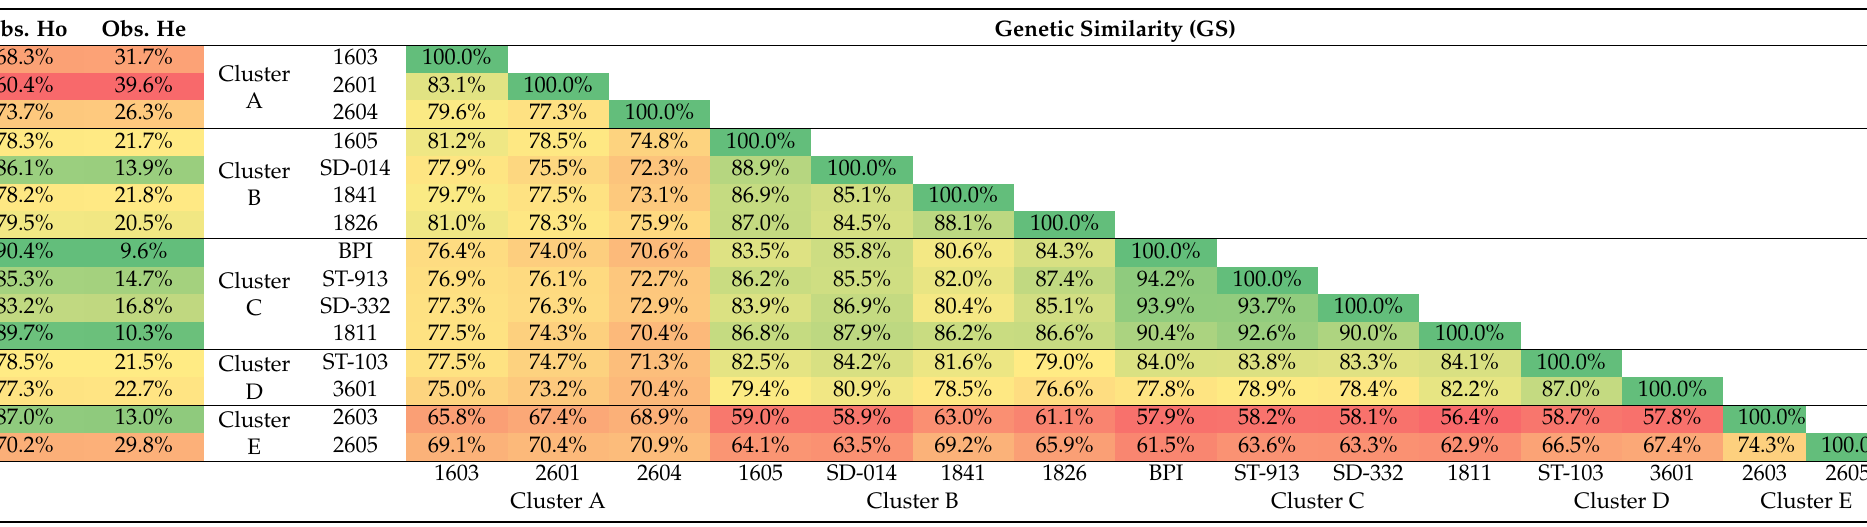
Table 5. Genetic Similarity matrix of 15 Lavandula individuals based the BLASTN analysis against S. indicum exome, and relative observed homozygosity (Obs. Ho) and heterozygosity (Obs. He).